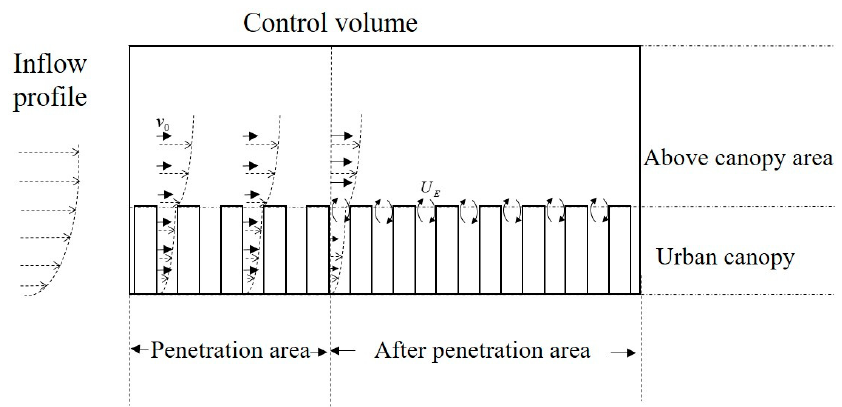
Figure 6. A sketch of the penetration area and after the penetration area.